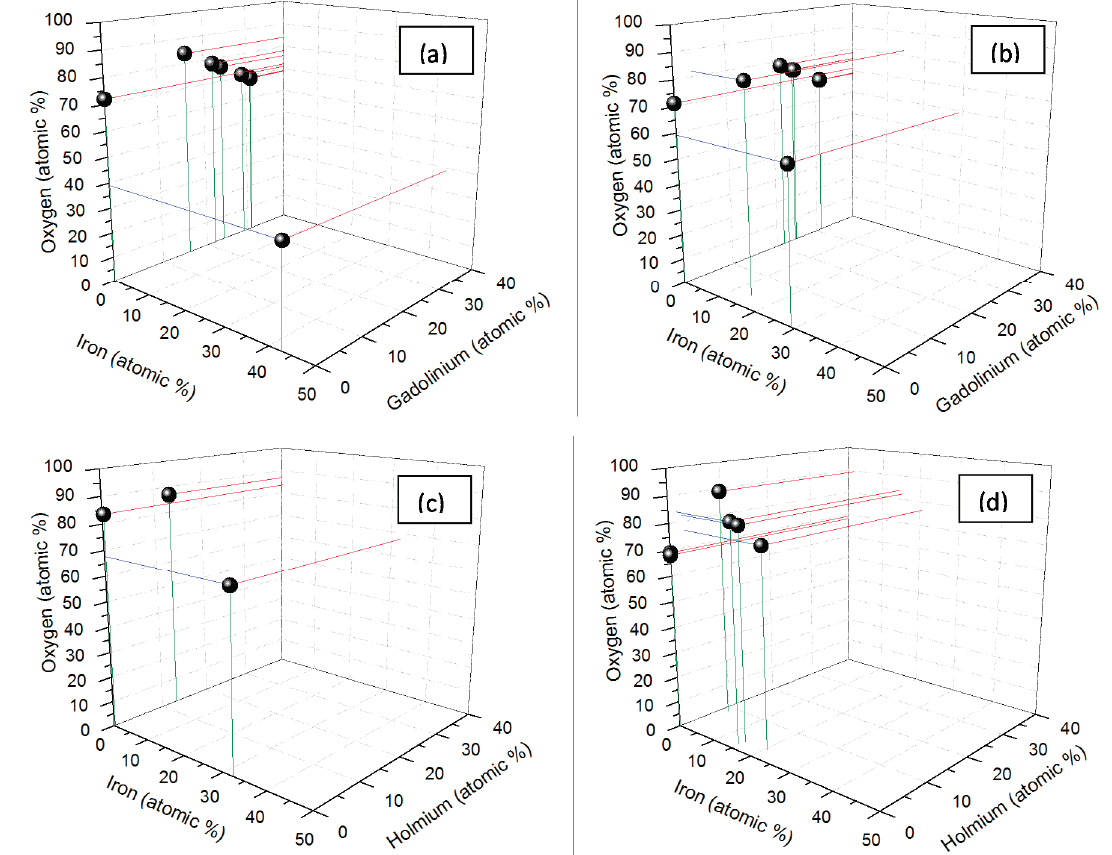
Figure 8. Composition of the nanoparticles determined by TEM-EDX for ( a ) the chemically-synthesized Fe–Gd–O; ( b ) the enzymatically-synthesized Fe–Gd–O; ( c ) the chemically-synthesized Fe–Ho–O; and ( d ) the enzymatically-synthesized Fe–Ho–O. Some points reflect multiple overlapping